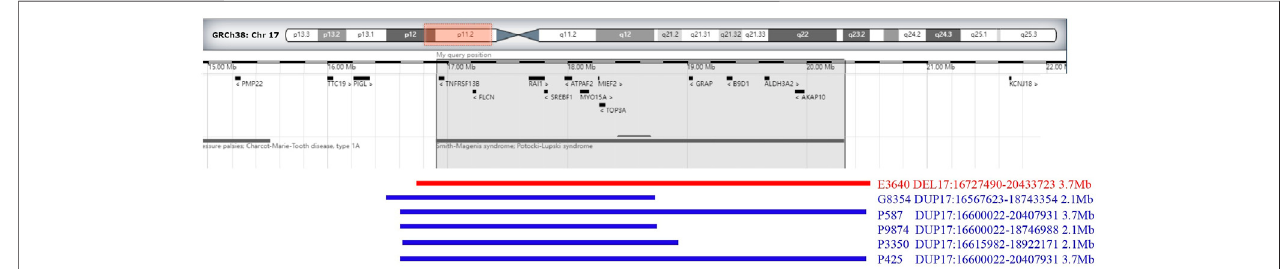
FIGURE 1 | Chromosome 17p 11.2 imbalance detected by SNP-array. In fetus E3640, the SNP-array revealed that the microdeletion of the CNV in 17p11.2 involved a 3.7 Mb fragment and contained 38 OMIM genes (including RAII ). In fetuses G8354, P587, P9874, P3350, and R425, the SNP-array revealed that he microduplication of the CNV in 17p11.2 involved about 2.1 – 3.7 Mb fragment size and contained 21 – 38 OMIM genes (including RAII